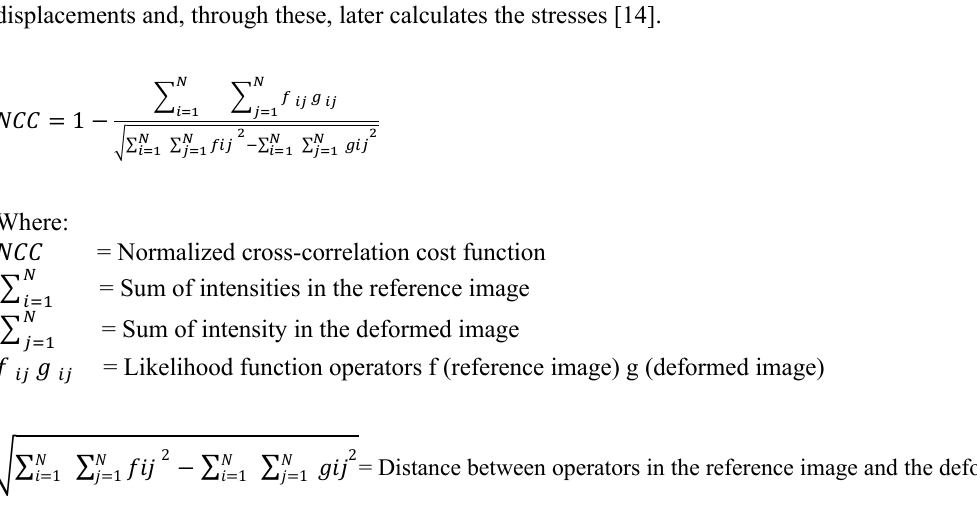
Each block is a set of pixels and the objective of the algorithm is to determine its new position through